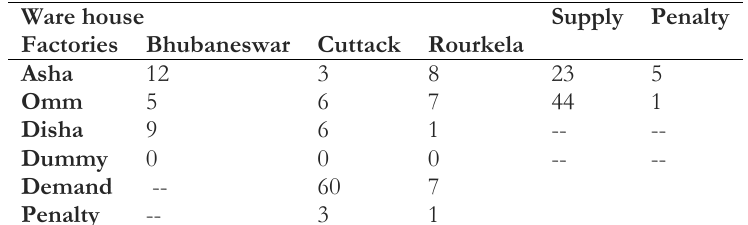
Table 8. 4 th Penalties allocation.